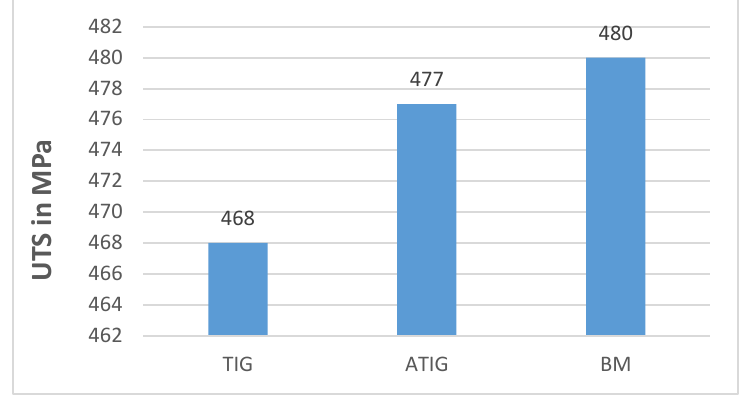
Figure 11. Tensile test results. Table 7. Mesurments of tensile strenght and standards deviation of TIG and ATIG (optimal flux).